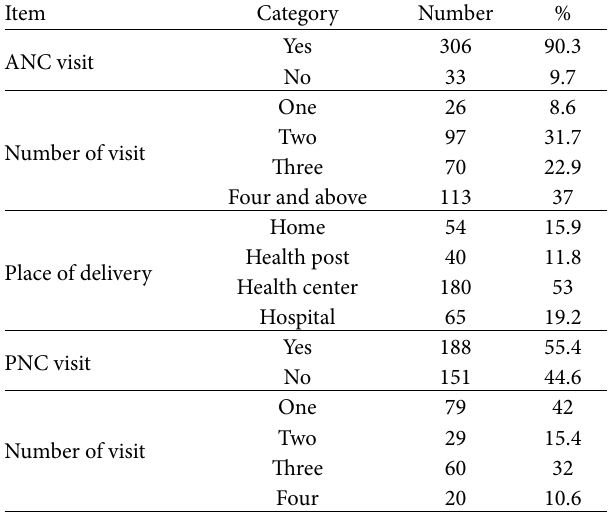
Table 2: Obstetric history of women whose child age was less than 12 months in Farta woreda, Northwest Ethiopia,